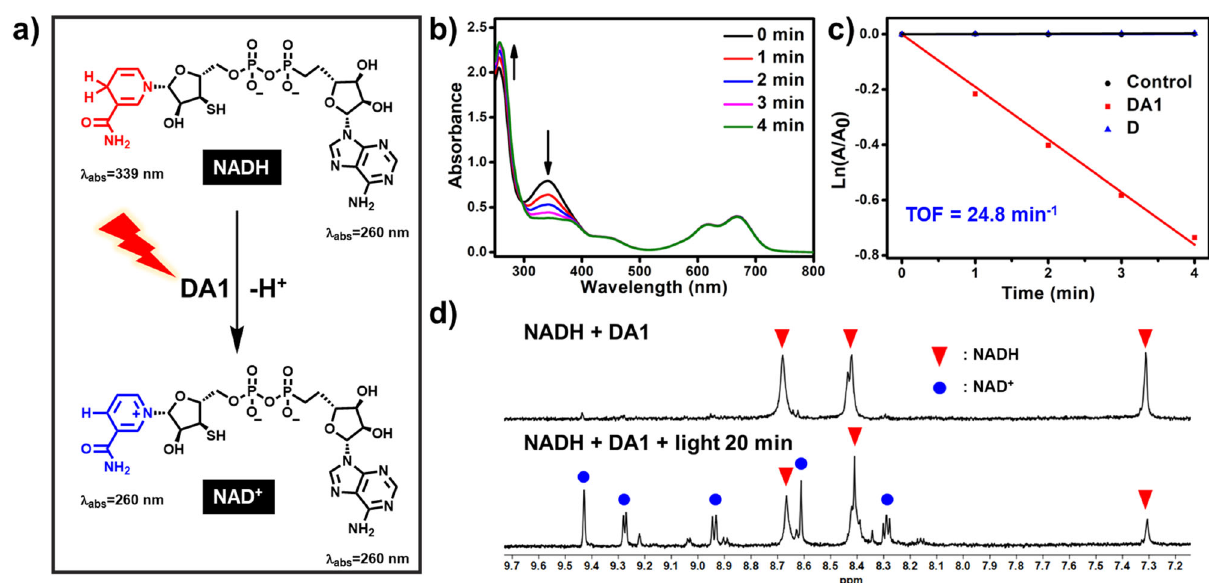
Fig. 4 | Oxidation of NADH. a Schematic illustration of the photocatalytic NADH/ NAD + transformation. b The oxidation of NADH (100 μ M) by DA1 (10 μ M) upon irradiation (660nm, 20mWcm − 2 ) in PBS solution, as monitored by ultraviolet-